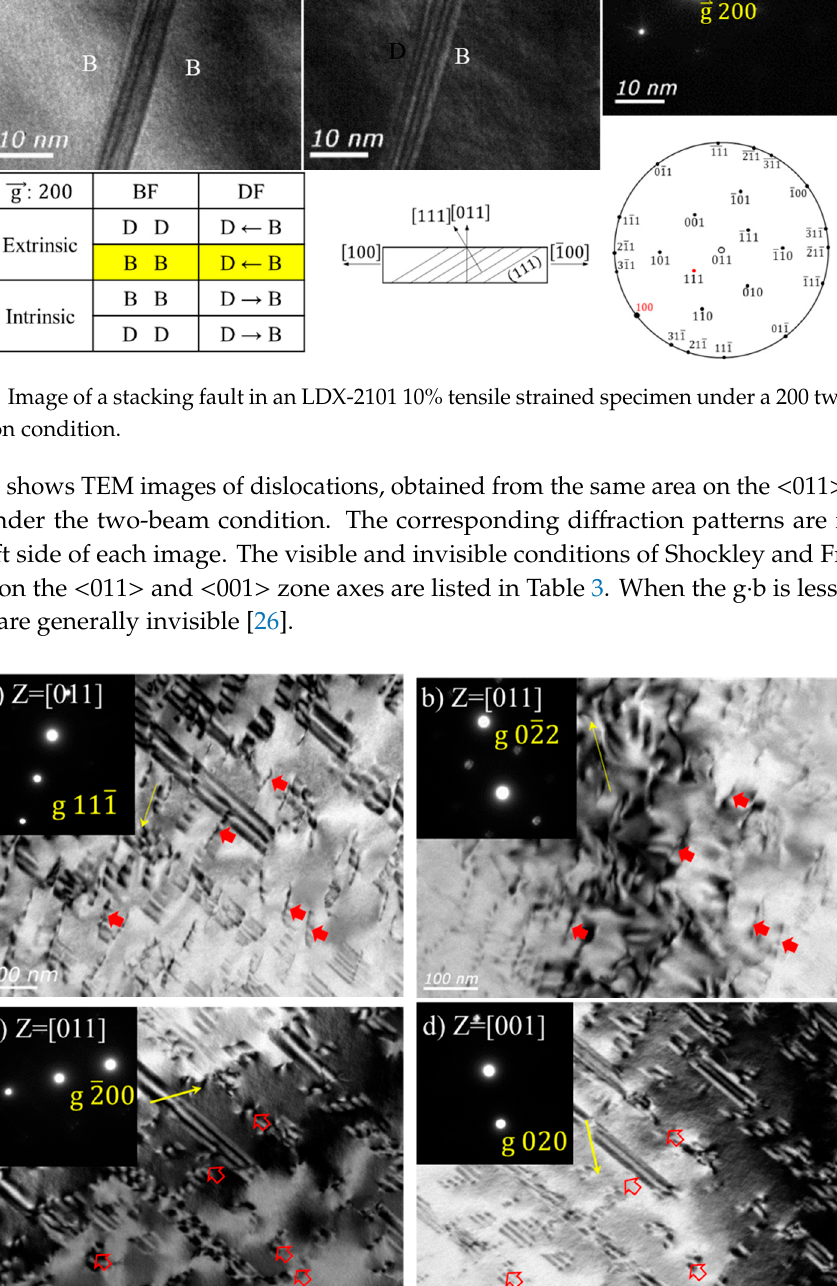
Figure 8. Image of a stacking fault in an LDX-2101 10% tensile strained specimen under a 200 two- beam diffraction condition.